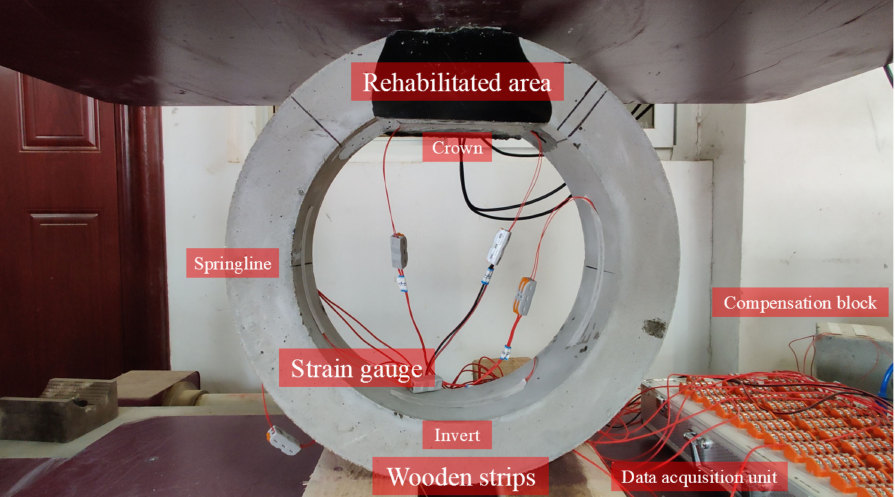
Figure 8. Layout of pipe installation in